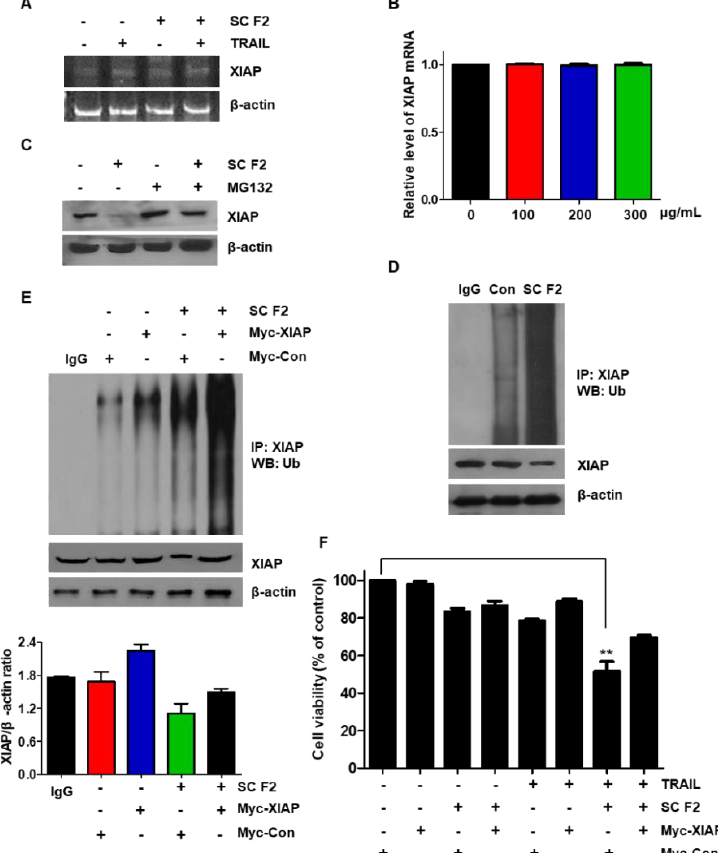
Figure 5. XIAP plays a role in the sensitization function of SC F2. DLD-1 cells were treated with SC